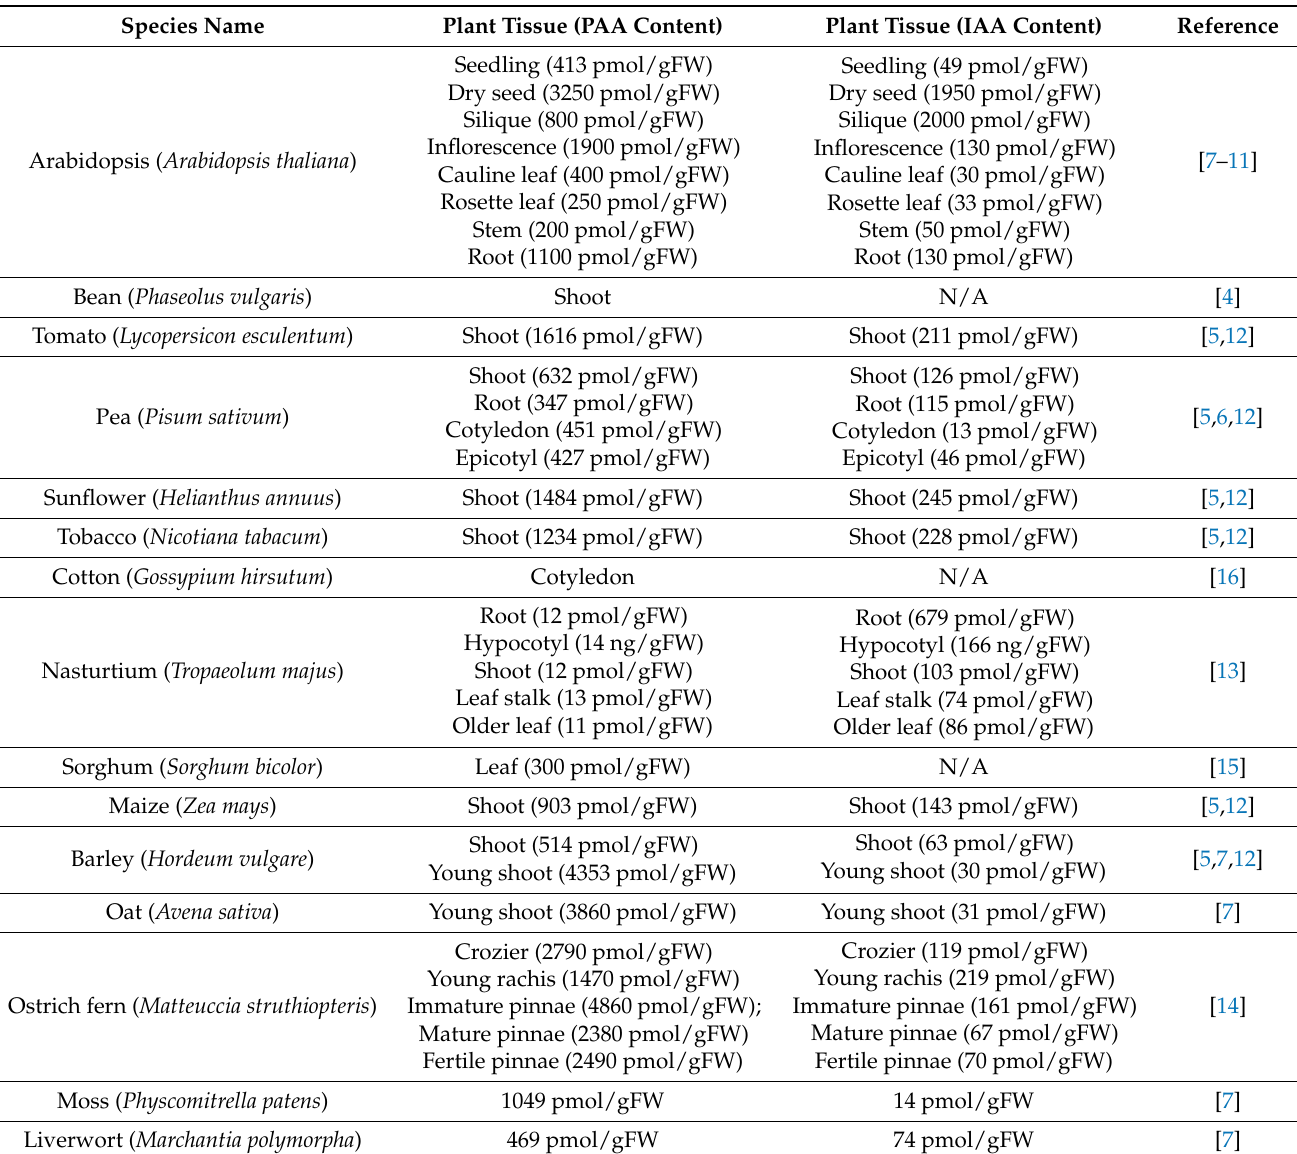
Table 1. Occurrence of PAA in plants, showing plant tissue, PAA, and IAA contents (if